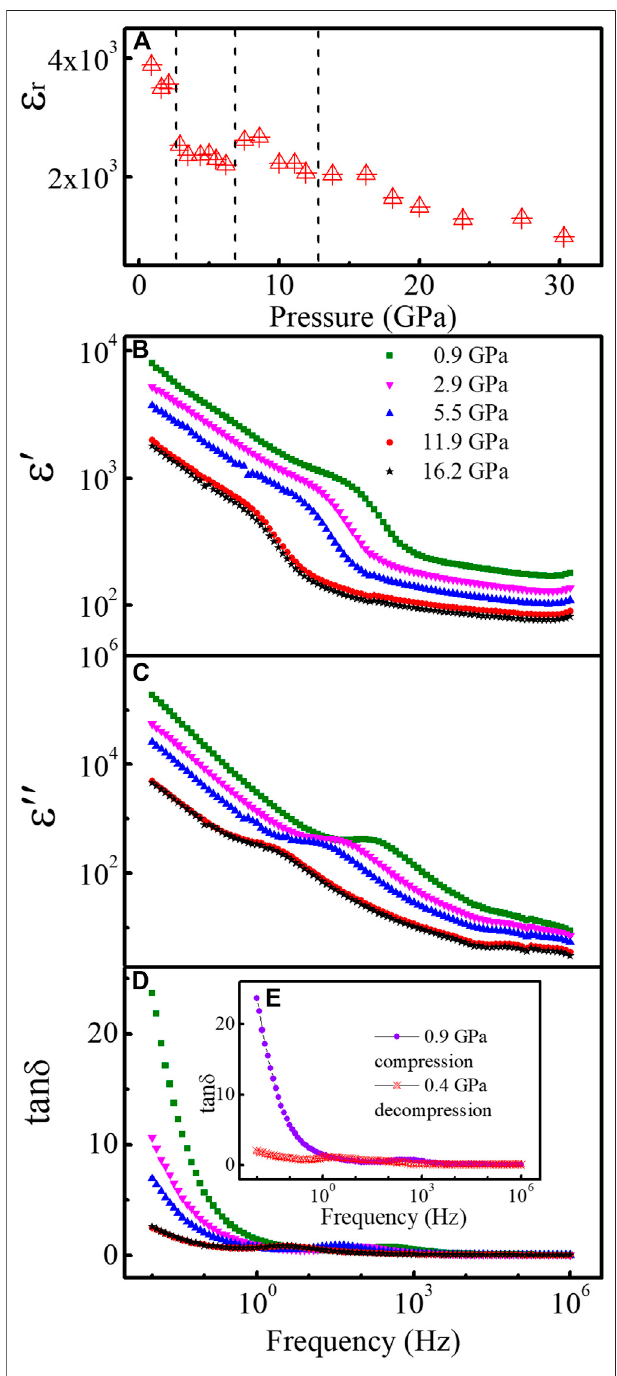
FIGURE 6 | (A) Variation of the relative permittivity ε r with pressure. (B – D) Frequency dependencies of , ε ′ , ε ″ and tan δ of phenanthrene under different pressures. Inset shows the dielectric loss factor (tan δ ) at 0.9 GPa during compression and at 0.4 GPa after decompression.